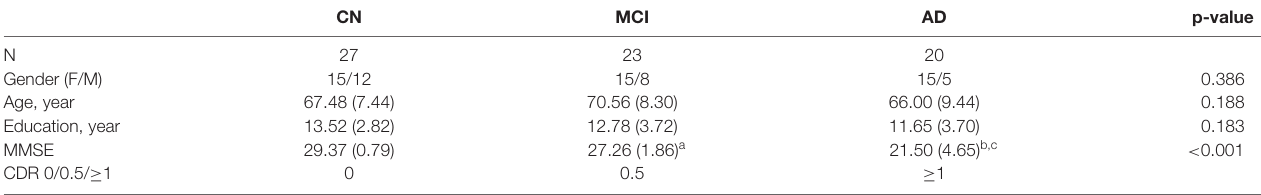
TABLE 1 | Demographic and clinical